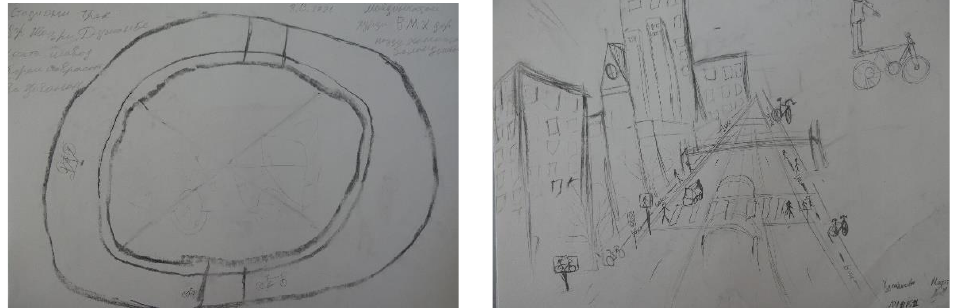
Figure 11. ( left ) A 2021 workshop participant offers a vision of a car-free area for cyclists and pedestrians; ( right ) another 2021 workshop participant draws an integrated street model where pedestrians, cyclists, and traffic are all accommodated (courtesy of the Young Generation of Tajikistan).